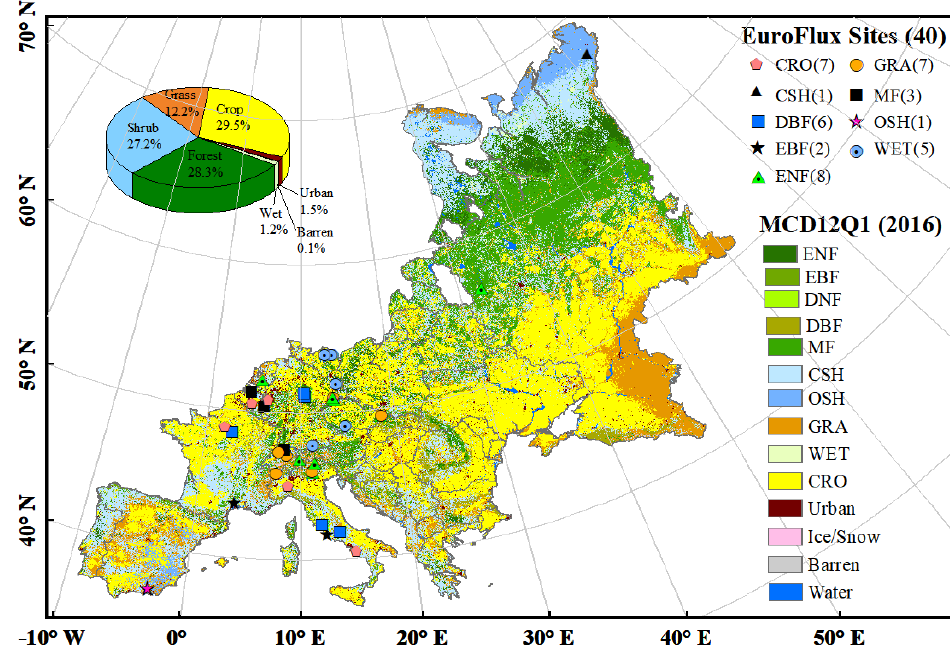
Figure 1. Spatial distribution of 40 EuroFLUX sites and land cover classification from MCD12Q1 in 2016 in Europe. Abbreviations: croplands (CRO), closed shrublands (CSH), deciduous broadleaf forest (DBF), deciduous needleleaf forest (DNF), evergreen broadleaf forest (EBF), evergreen needleleaf forest (ENF), grasslands (GRA), mixed forest (MF), open shrublands (OSH), and wetland (WET).